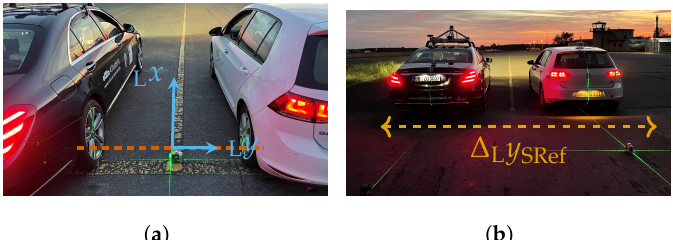
Figure 3. Dual-car calibration setup. Super-reference is provided by perpendicular cross line laser lines. ( a ) Zero longitudinal offset (i.e., ∆ L x SRef = 0) between the vehicles is verified by cross line laser through center of rear axles. ( b ) Lateral offset is obtained by measuring the distance between cross line laser lines focusing along the vehicle’s middle axis.